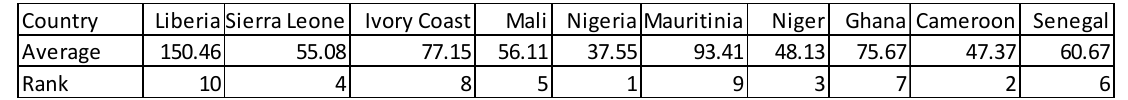
Figure A4. Openness (OPEN).